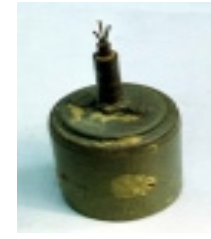
Figure 20 –PP Mi-Sr II mine Рис . 20 – Мина PP Mi-Sr II Слика 20 – Мина PP Mi-Sr